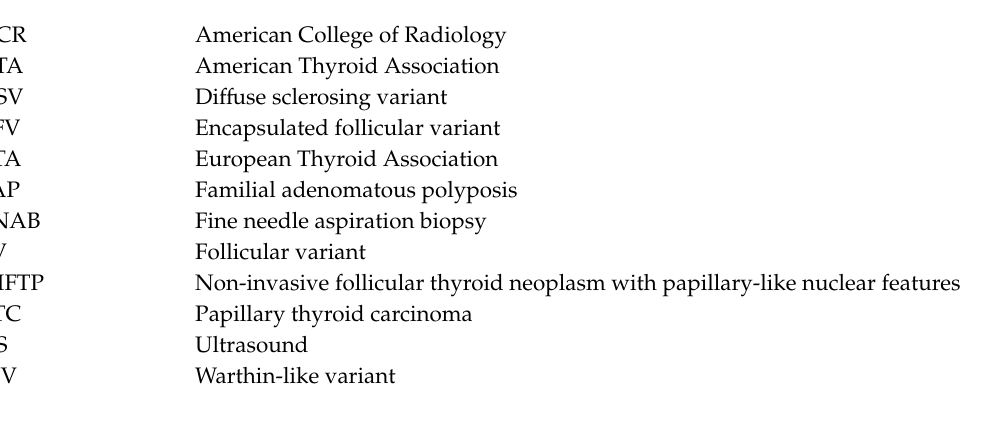
Figure S1: Study selection flowchart outlining the protocol adopted in this review based on the Preferred Reporting Items for Systematic Reviews and Meta-Analyses (PRISMA) Four-Phase Flow